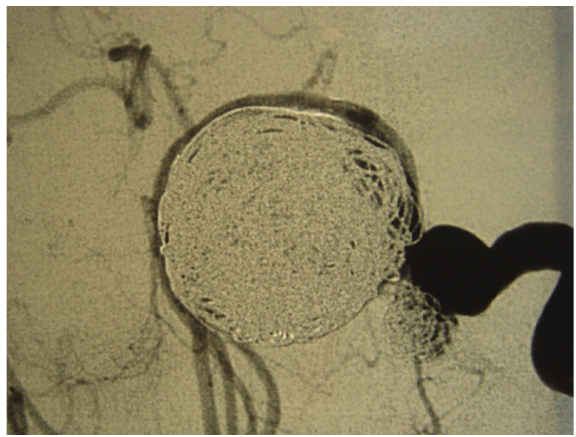
Figure 4: Digital angiography of the aneurysms after the second successful embolization.